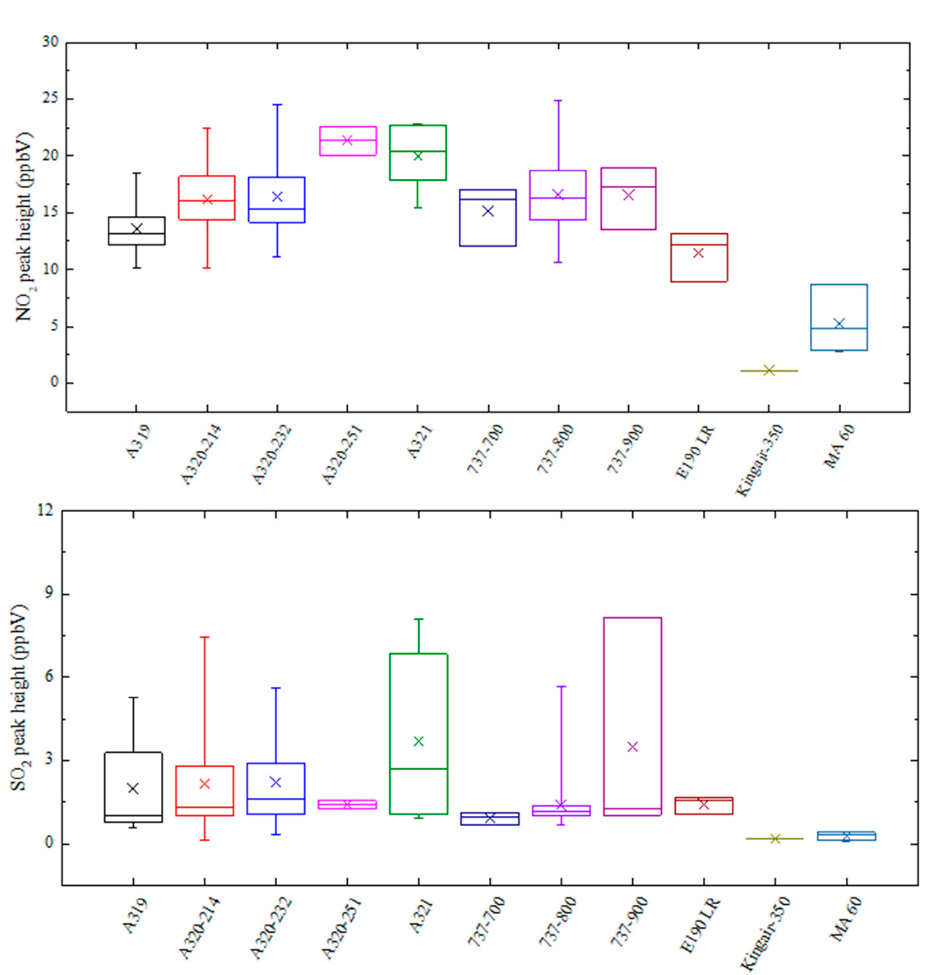
Figure 8. Boxplots of NO 2 and SO 2 peak heights for aircraft emissions data for various aircraft types.